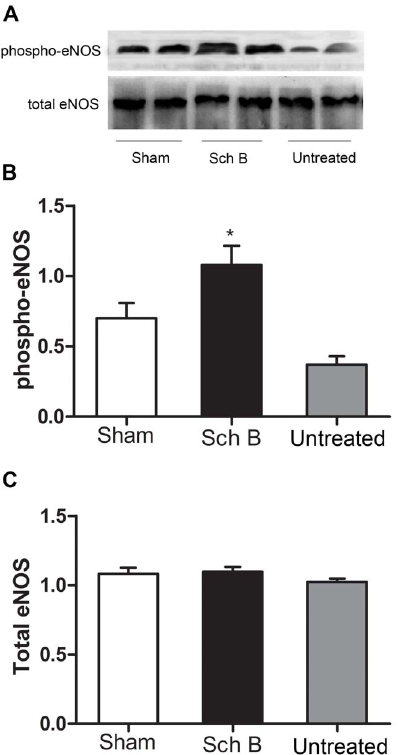
Figure 6. Analysis of eNOS expression in LV myocardium of mice. (A) Western blot analysis of total eNOS and phospho-eNOS Ser1177 expression. (B) Densitometry for phospho-eNOS expression. (C) Densitometry for total eNOS expression. n=6 per group, * P , 0.05 versus untreated group, + P , 0.05 versus sham-operated group.